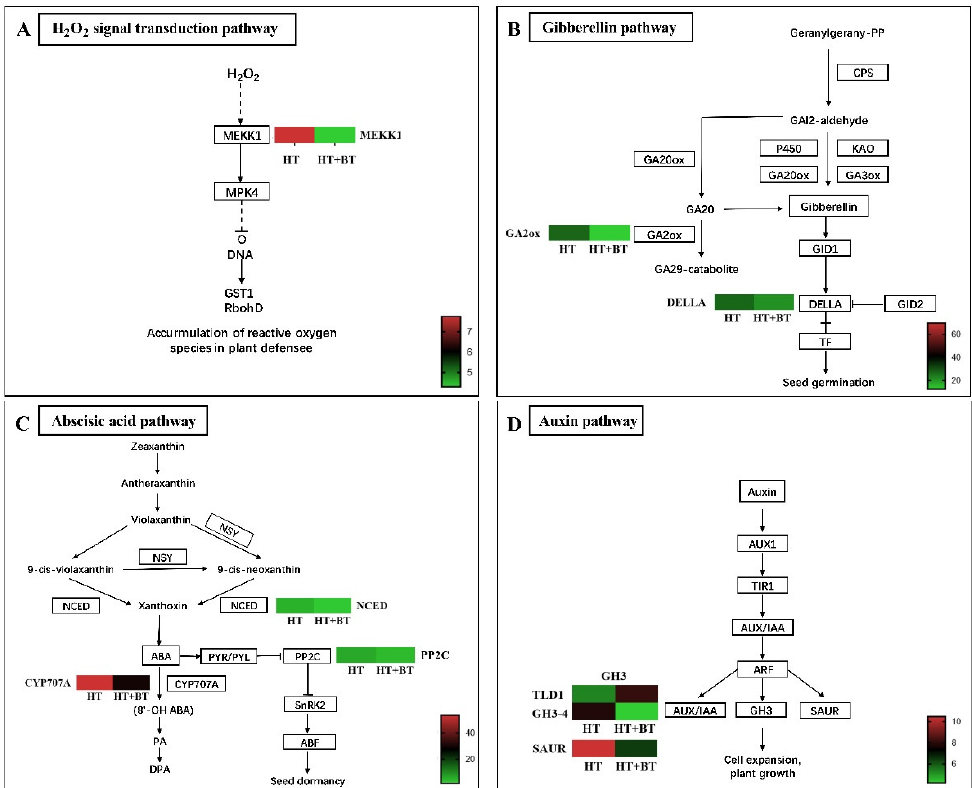
Figure 7. Expression profiles of DEGs in reactive oxygen species accumulation and three endogenous hormone-related pathways: ( A ) expression profiles of DEGs related to the H 2 O 2 signal transduction pathway under HT and HT + BT treatments; ( B ) expression profiles of DEGs related to the GA pathway under HT and HT + BT treatments; ( C ) expression profiles of DEGs related to the ABA pathway under HT and HT + BT treatments; ( D ) expression profiles of DEGs related to the IAA pathway under HT and HT + BT treatments. The sample names are shown at the bottom of the figure. We indicate changes in expression levels by changes in color: green indicates a lower expression level, whereas red indicates a higher expression level. All data shown reflect the average mean of three biological replicates ( n = 3). Means with different letters in each treatment represent a significant difference of p ≤ 0.05.